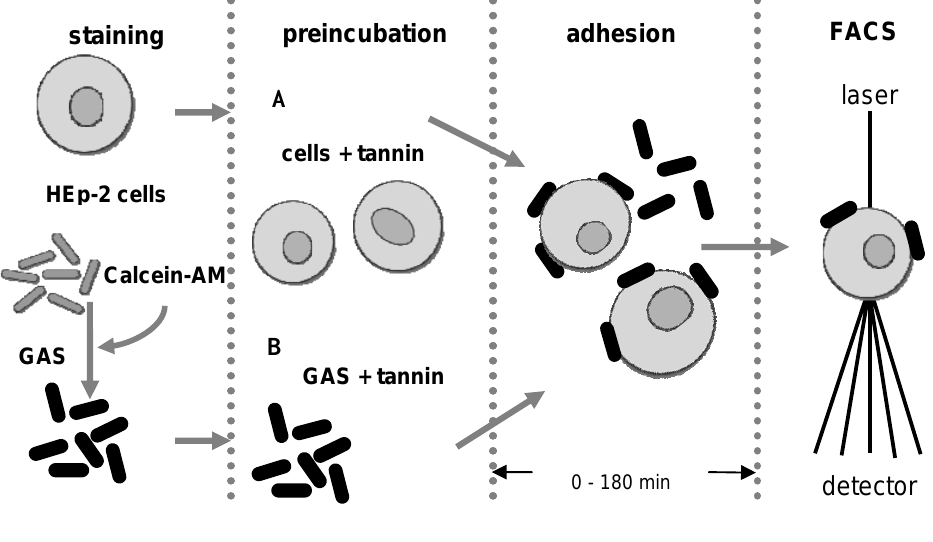
Figure 1. Flow cytometry-based anti-adhesive